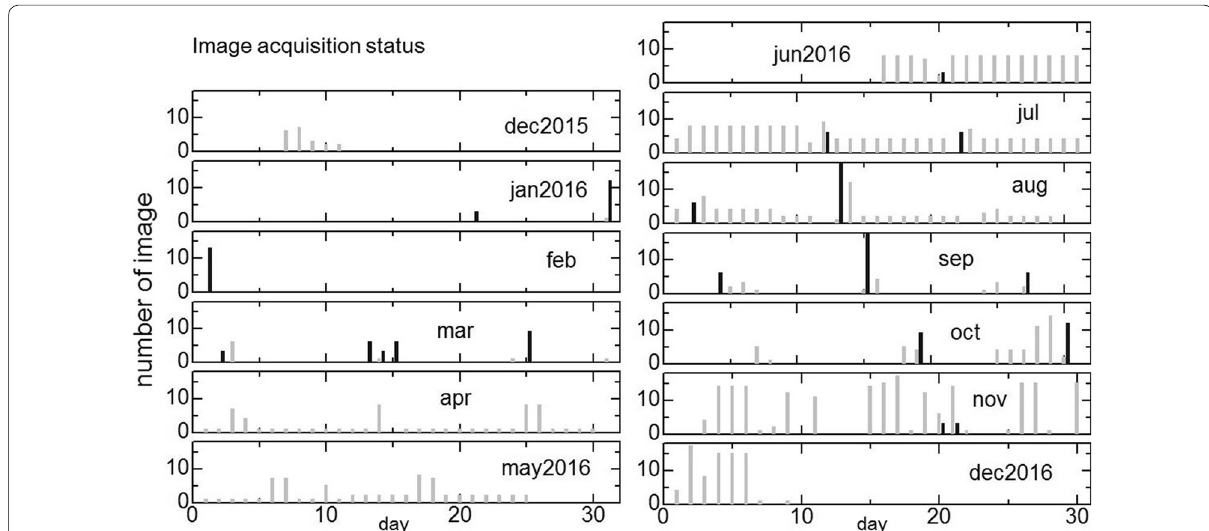
Fig. 3 Image acquisition status for Dec. 2015–Dec. 2016. Each box represents 1 month. The vertical axis is for the number of available images, and the horizontal for the day in a month. Dayside is shown by gray and nightside by black vertical bars. A set of three nightside images are taken nearly simultaneously, and the black bar indicates total number of nightside images, so that one‑third of the black bars belongs to one wavelength. The 10‑day periodicity seen is due to Akatsuki’s orbital motion, and nightside images are concentrated around